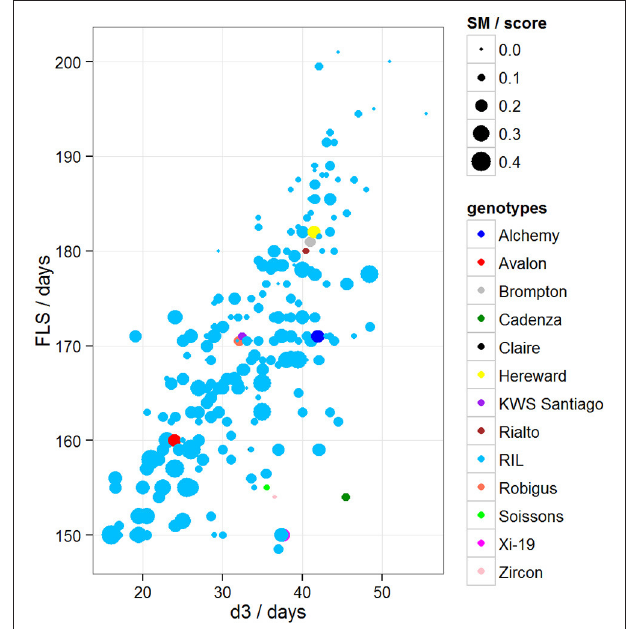
FIGURE 4 | Variation between d1 and FLS. Dot size represents FFLL/100 (divided by 100 to be able to show the dots in the plot). Blue dots correspond to RILs. Other colored dots correspond to MAGIC parents.